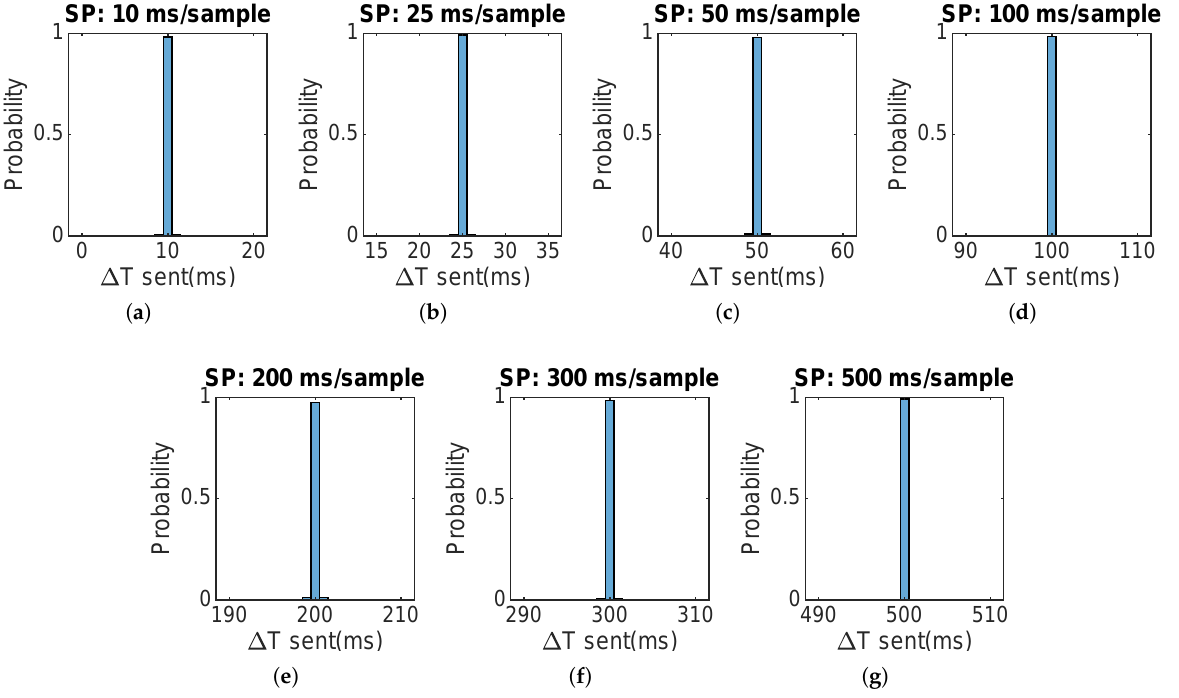
Figure 8. Sampling histograms for each sampling period tested. Each Sampling Period (SP) is indicated in the histogram title ( a – g